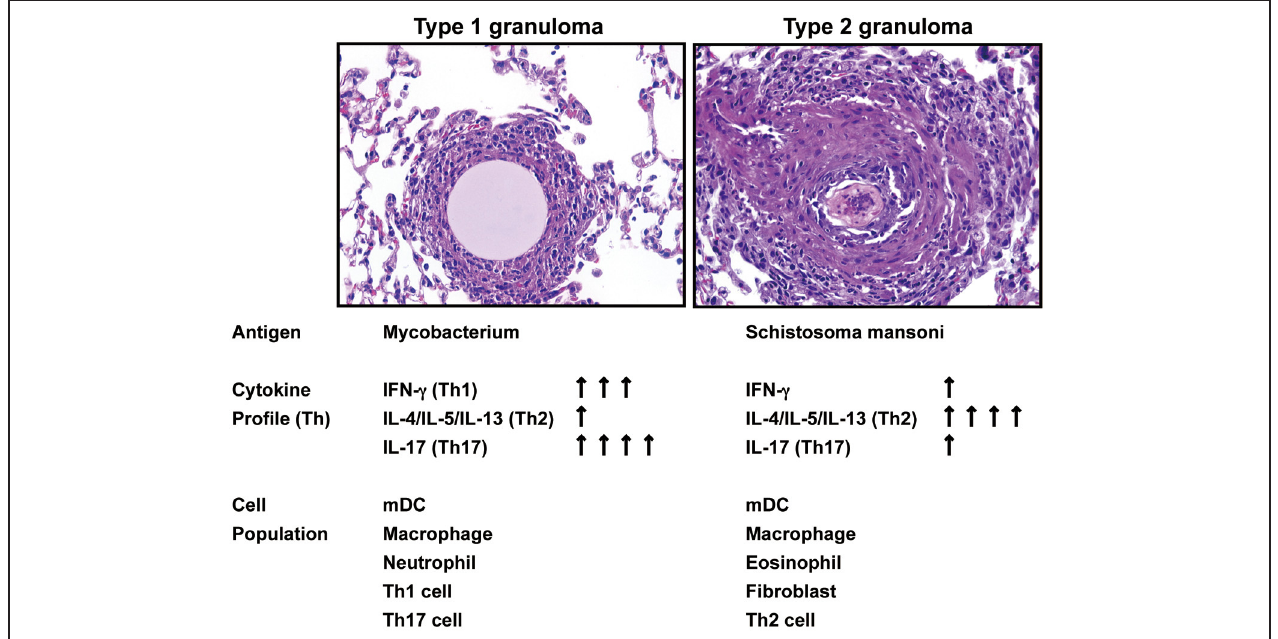
FIGURE 1 | Summary of Hematoxylin-and-eosin–stained sections showing the progression of type 1 and type 2 granuloma and the kinetic assessment of cytokine and cellular components.